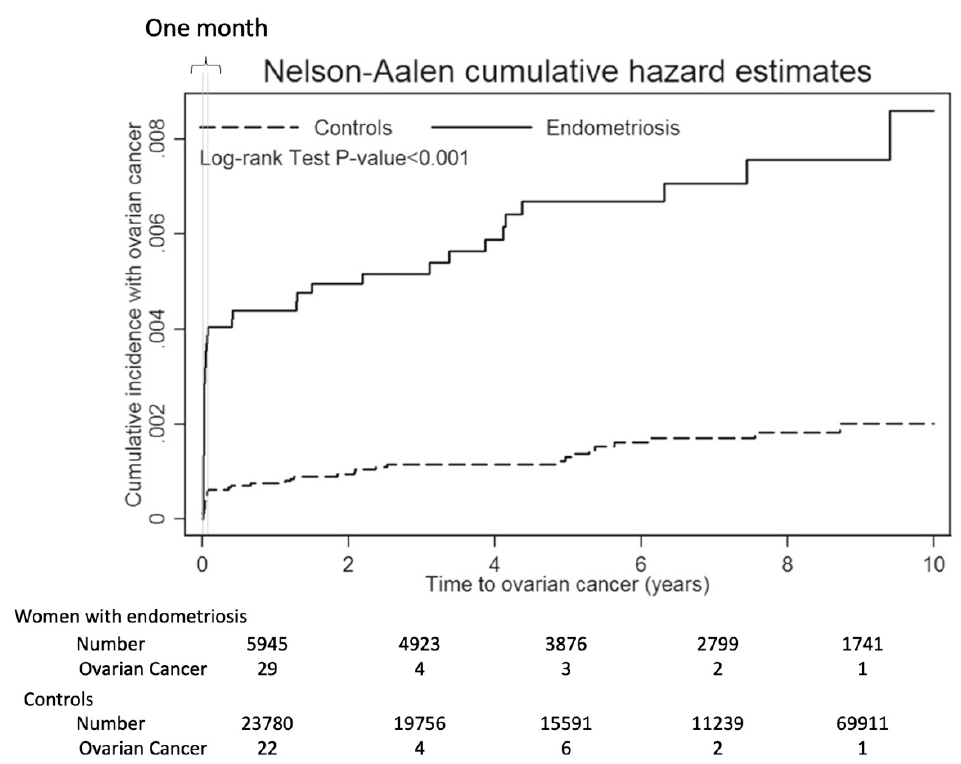
Figure 1. The actual cumulative curve for carcinogenesis from endometrial cysts. Graph showing that in 5945 women enrolled as endometriosis, 24 (0.4%) ovarian cancers developed within 30 days of enrollment. This figure was made by modifying a figure from BMC Cancer 2014 [27].